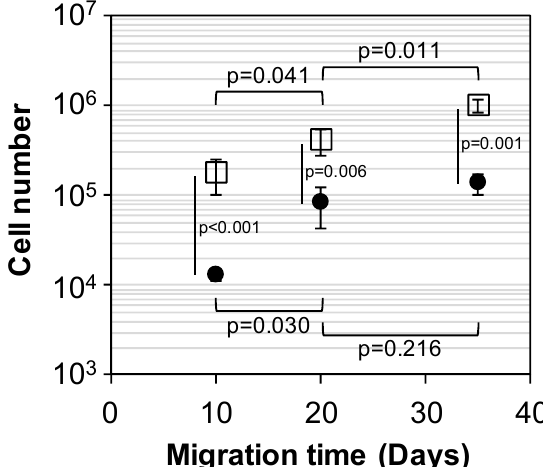
Figure 8. Cell number after 10, 20 and 35 days of fibroblast migration into PEUUF sca ff olds ( (cid:8) ) and PRP-PEUUF sca ff olds ( (cid:3) ) (the LMW fucoidan concentration in the aqueous phase of the HIPE used for functionalization = 10 mg mL ‒ 1 ; the PRP concentration used for bio-activation = 15 vol% (16 hours of incubation)).